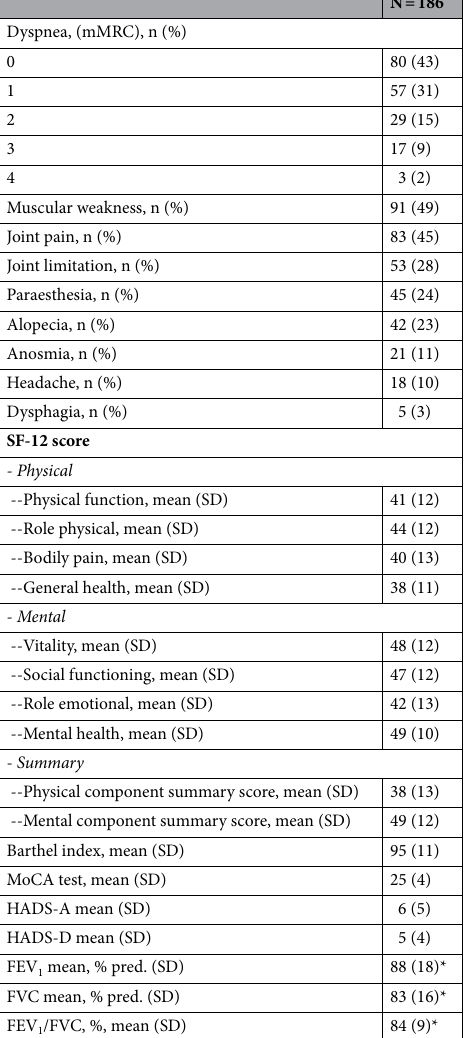
Table 3. Clinical results obtained in the outpatient assessment. mMRC Modified Medical Research Council (mMRC) dyspnea scale, SF-12 short form-12 health survey, MoCA Montreal Cognitive Assessment (MoCA)